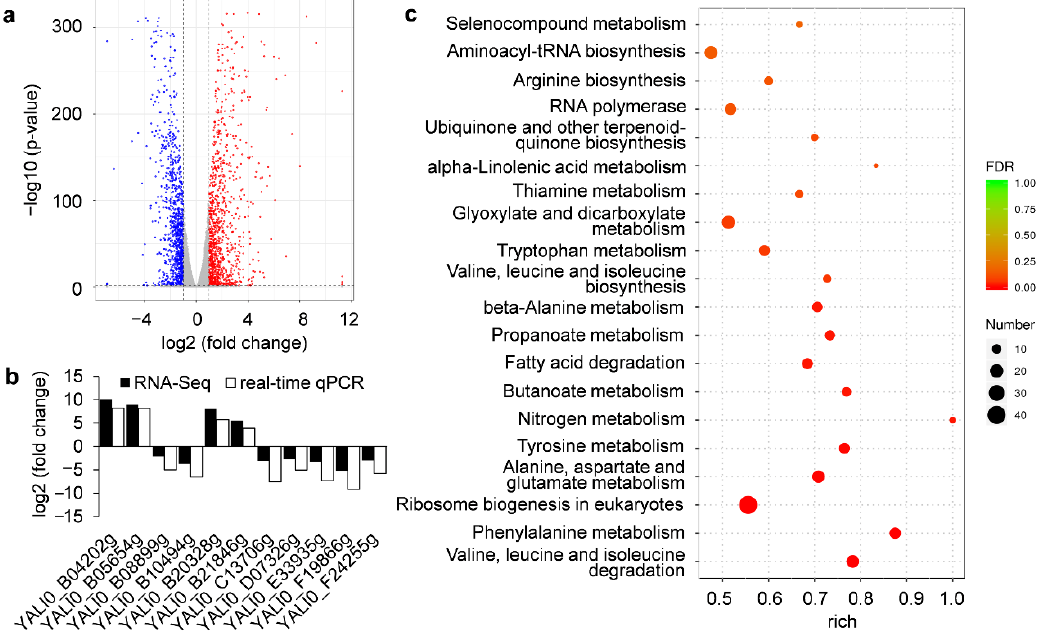
Figure 4. RNA profiling of Y. lipolytica in response to rapamycin; ( a ) A volcano map of the obtained genes; ( b ) Validation of RNA-Seq data using fluorescent real-time qPCR. The reference gene for normalization used in this study was 26S rRNA; ( c ) The top-20 enriched KEGG pathways in which the differentially expressed genes were involved after rapamycin treatment.